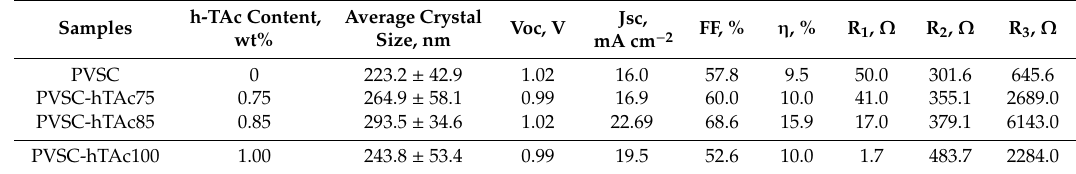
Table 2. Photovoltaic characteristics of PVSCs using h-TAc as the mesoporous layer. Samples